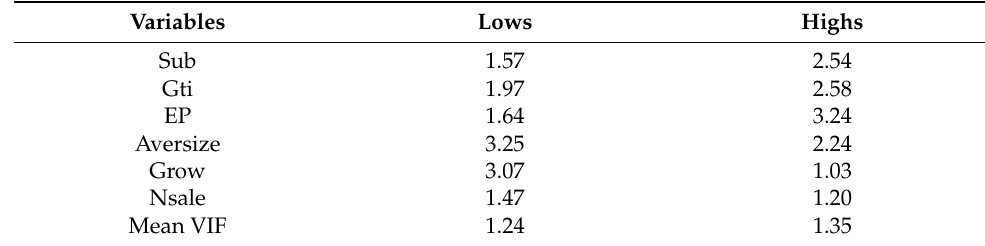
Table 4. Table of variance inflation